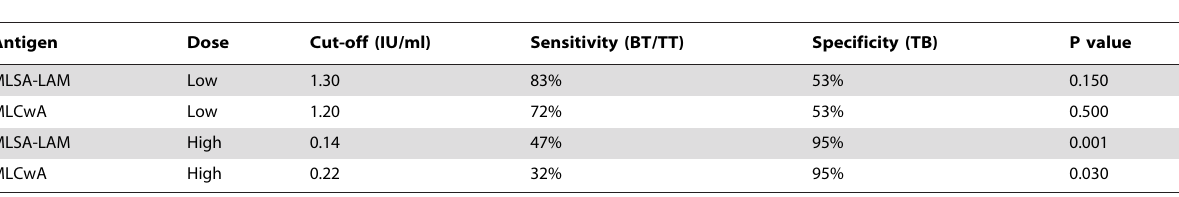
Table 4. Diagnostic test statistics – WB-IGRA a